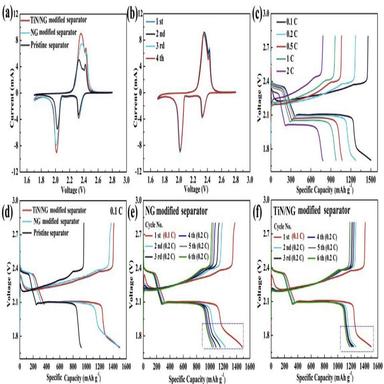
(a) Charge/discharge curves of the batteries with different separators at 1C. (b) EIS spectra of the batteries with different separators. (c) The rate performances of the batteries with different separators. (d) Cyclic performance of the batteries with different separators at 1C for 300 cycles.